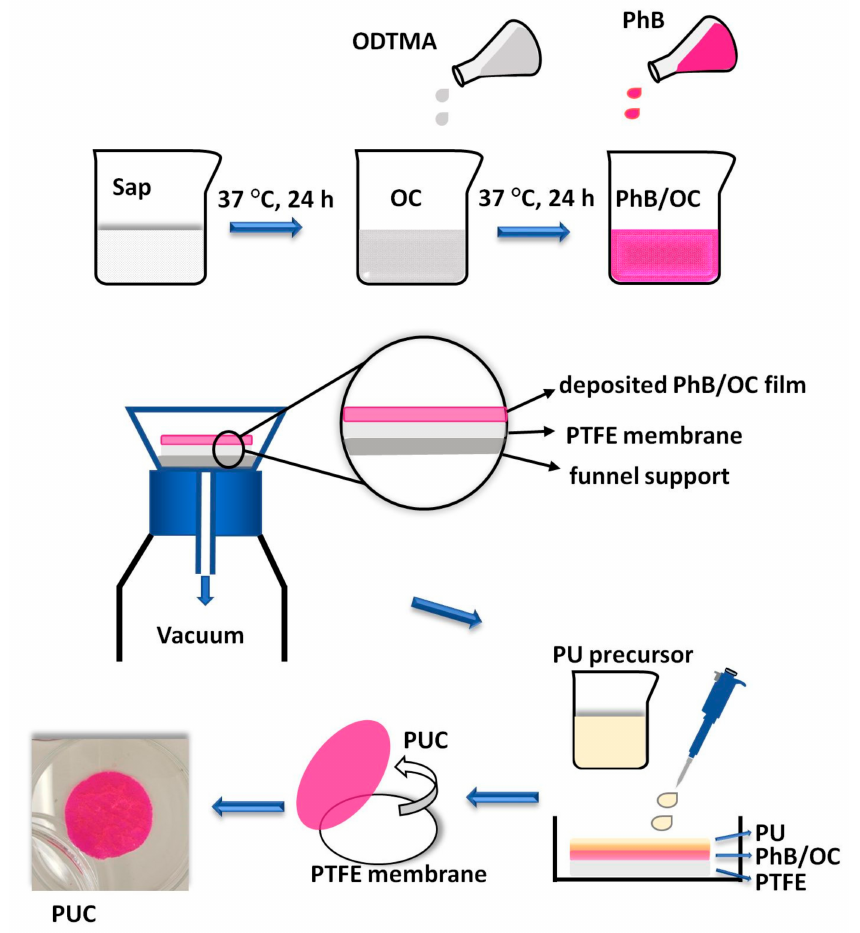
Figure 1. The schematic diagram on the preparation of polyurethane membranes with surface modified with phloxine B-functionalized organoclay. Sap—saponite, ODTMA—